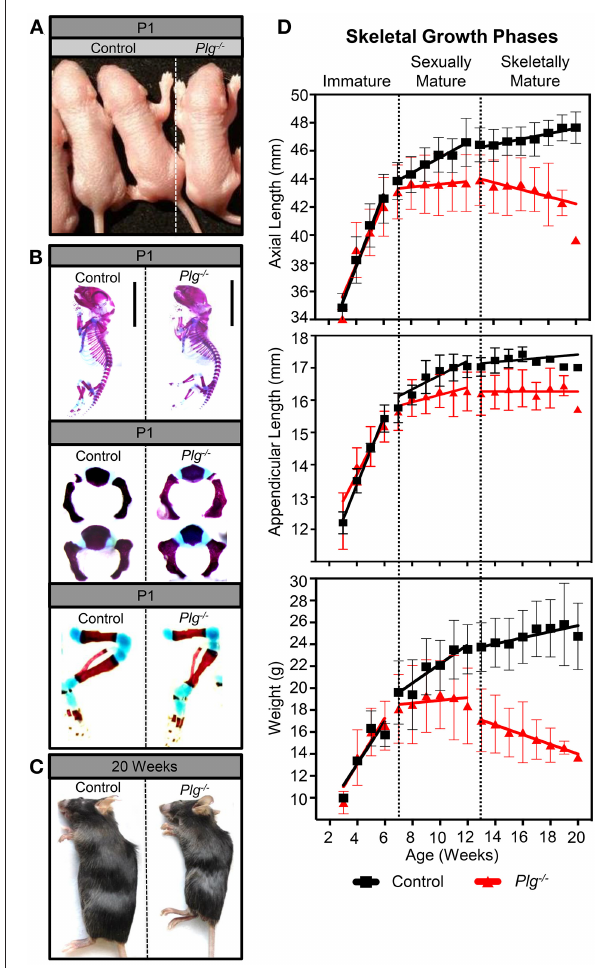
FIGURE 1 | Plasminogen deficiency does not affect prenatal growth or skeletal development. At postnatal day 1 (P1), (A) gross examination and (B) alcian blue/alizarin red staining (blue indicates cartilage; red indicates mineralized bone) of control (wild-type littermates, WT) and Plg − / − male mice demonstrate no observable differences in prenatal growth and skeletal development. However, after sexual and skeletal maturity (20 weeks of age), (C) gross examination of Plg − / − mice shows stunted growth compared to control littermates. (D) Serial measurements of axial and appendicular skeletal lengths (measured radiographically) and body weights of WT and Plg − / − mice during immature (3–6 weeks of age), sexually mature (7–12 weeks of age), and skeletally mature (13–20 weeks of age) growth phases. Error bars represent SD. See Supplementary Table 1 for number of mice quantified and Supplementary Table 2 for statistical analyses of growth rates. Statistical differences between WT and Plg − / − mice growth rates were examined by the use of analysis for covariance